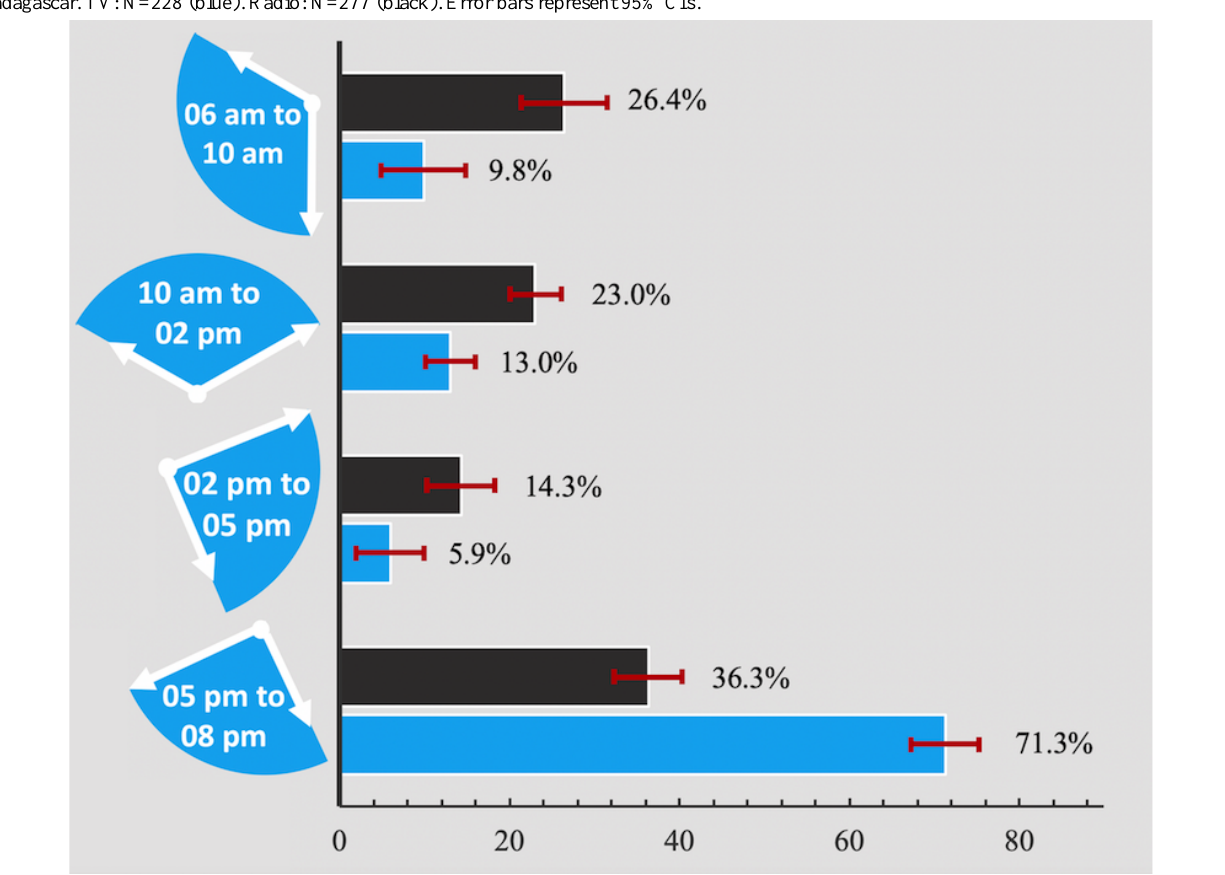
Figure 3. Day time of media consumption among pregnant women and new mothers in Antananarivo (Atsimondrano and Renivohitra